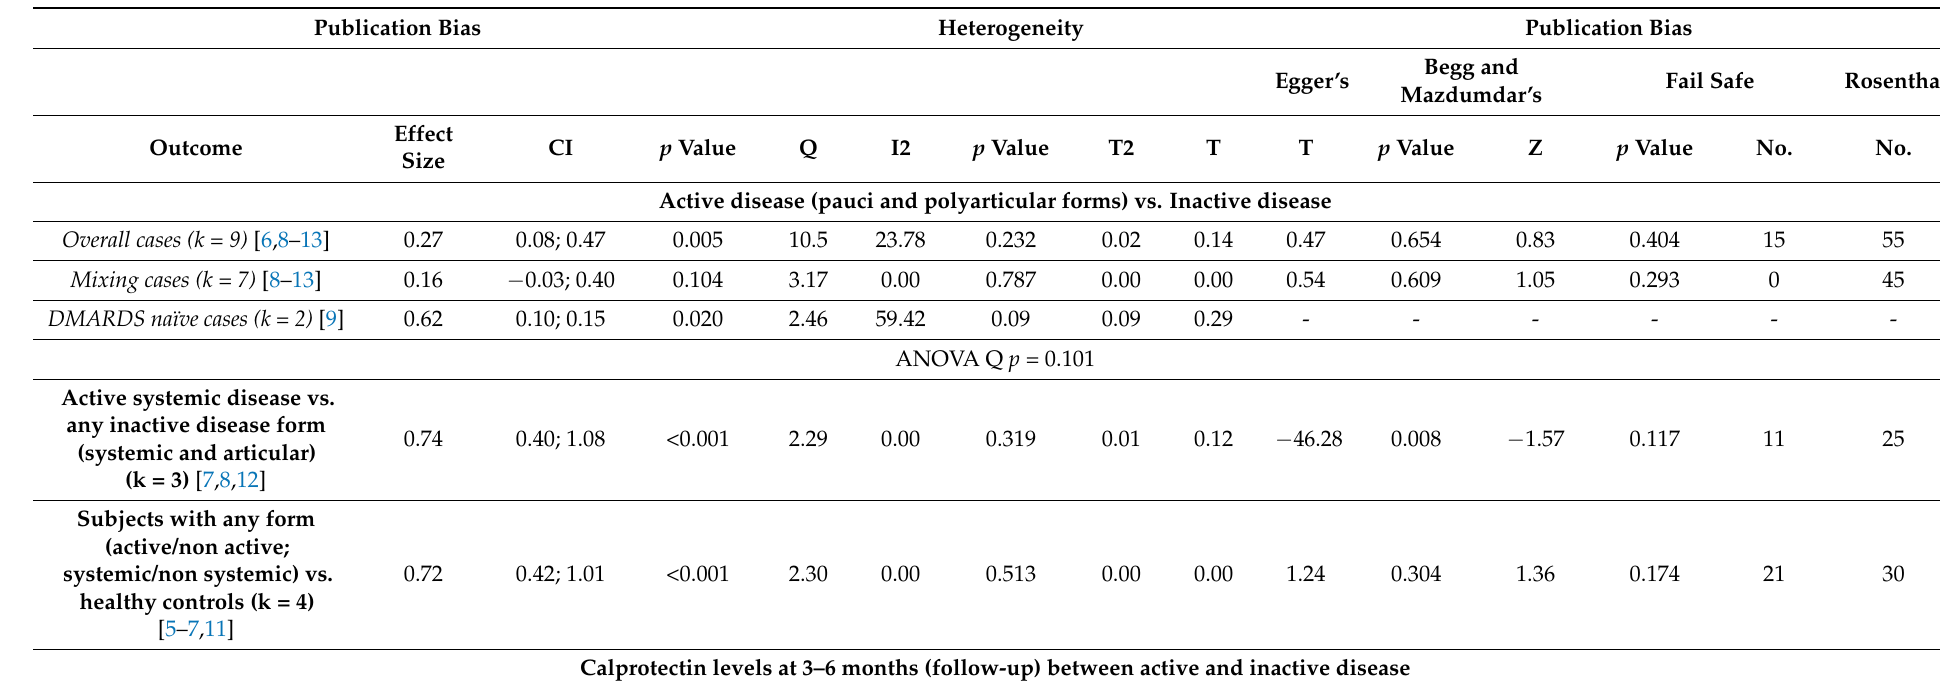
Table 1. Meta-analysis